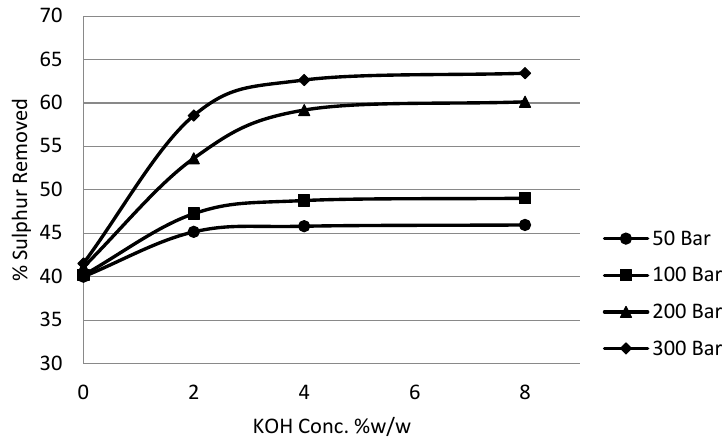
Figure 15. Effect of KOH concentration on organic sulphur removal.